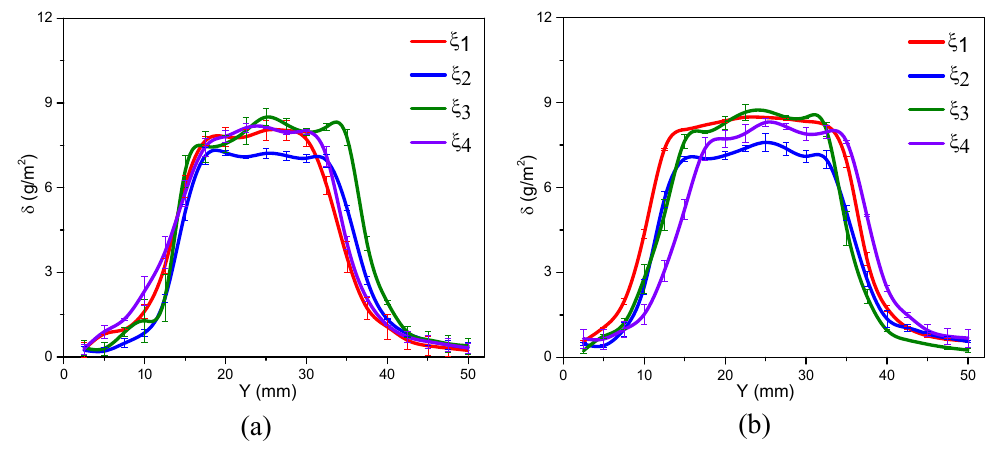
Figure 6. Longitudinal section profiles of adhered fuel film for ( a ) B15 and ( b ) B25 blends under dry wall conditions.